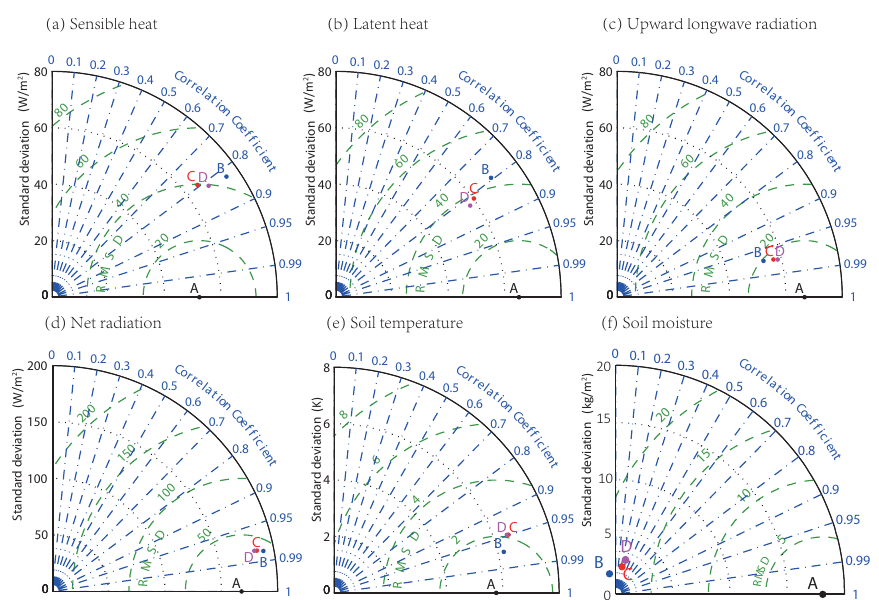
Figure 6. Taylor diagram of simulated fluxes during calibration period (1 January 2009 to 31 December 2009).